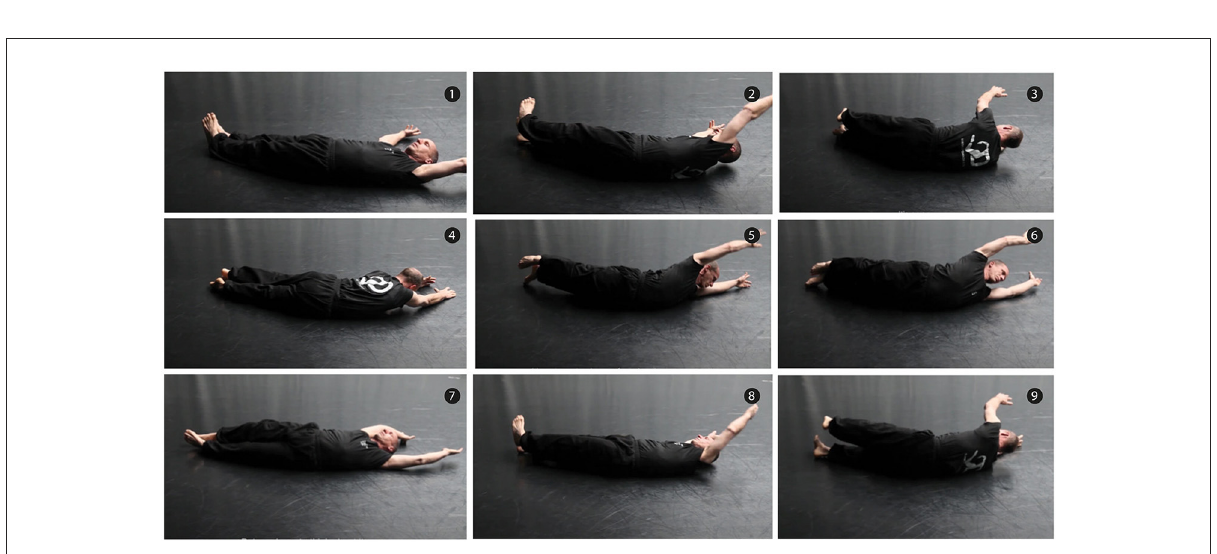
FIGURE7 Contact Improvisation: Sequence of working floor movement called “Crescent roll.” The Choreographer Mark Young in demonstration; Excerpts from the documentary film “Mark Young in Search of Spirality,” (http://www.flamencoinvestigacion.es/mark-young/).